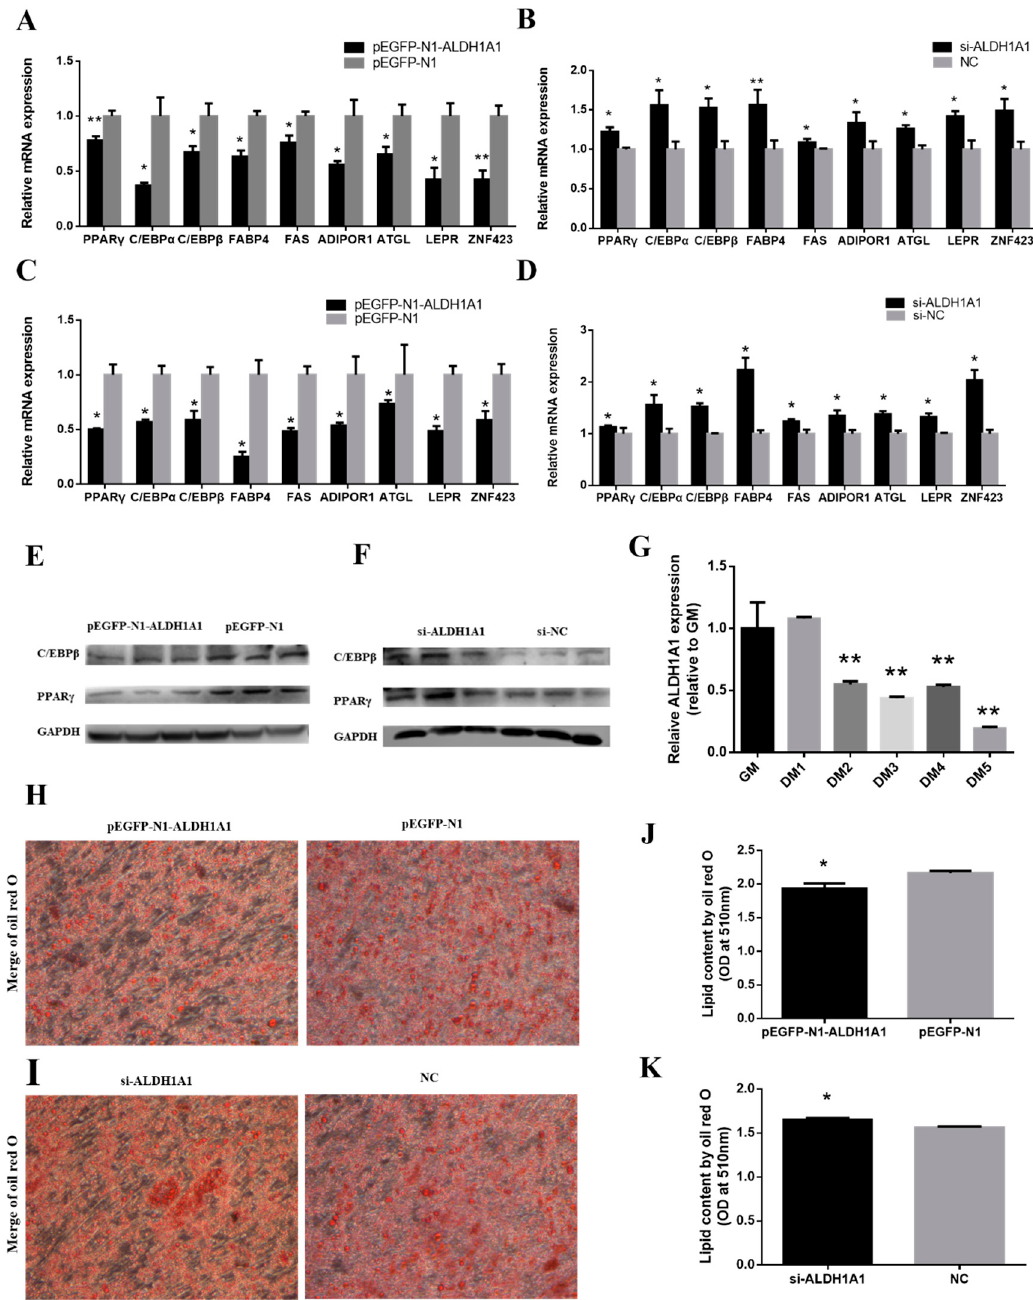
Figure 4. ALDH1A1 represses chicken preadipocytes’ differentiation through the PPAR γ pathway. ( A,B ) Relative mRNA levels of adipocyte differentiation-related genes after transfection in primary preadipocytes during differentiation, determined by RT-qPCR at 48 h post-transfection ( n = 6). ( C, D ) Relative mRNA levels of adipocyte differentiation-related genes after transfection in ICP during differentiation, determined by RT-qPCR at 48 h post-transfection ( n = 6). ( E,F ) The protein level of adipocyte differentiation-related genes after transfection and three days differentiation in primary preadipocytes ( n = 3). ( G ) The ALDH1A1 relative expression of primary preadipocytes during differentiation for five days was detected by RT-qPCR used Dunnett’s test ( n = 6, * p < 0.05; ** p < 0.01). ( H-K ) Oil Red O test and lipid droplet quantification in primary preadipocytes after differentiation for five days ( n = 6) , scale bar: 50 μ m. In all panels, data are presented as the mean ± S.E.M. of three biological replicates. The statistical significance of differences between means was assessed using an unpaired Student’s t -test (* p < 0.05; ** p < 0.01) or Dunnett’s test (* p < 0.05; ** p < 0.01).